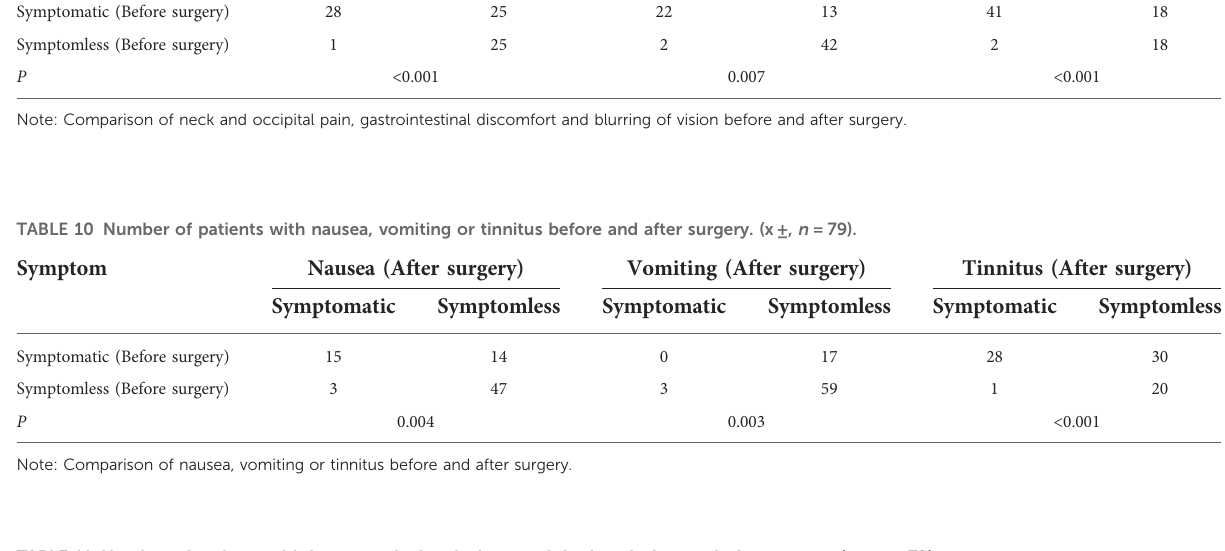
TABLE 11 Number of patients with hypomnesia, headache or palpitations before and after surgery. (x±, n =79).